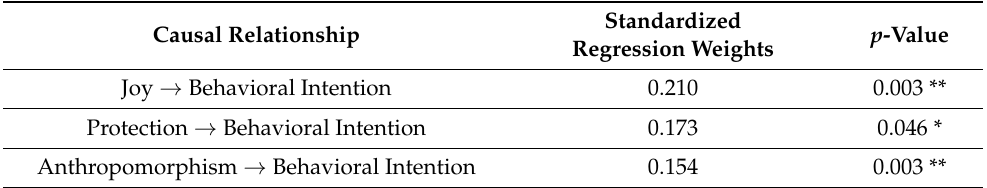
Table 11. Hypothesis test analysis: the path coefficient from joy, protection, and anthropomorphism to behavioral